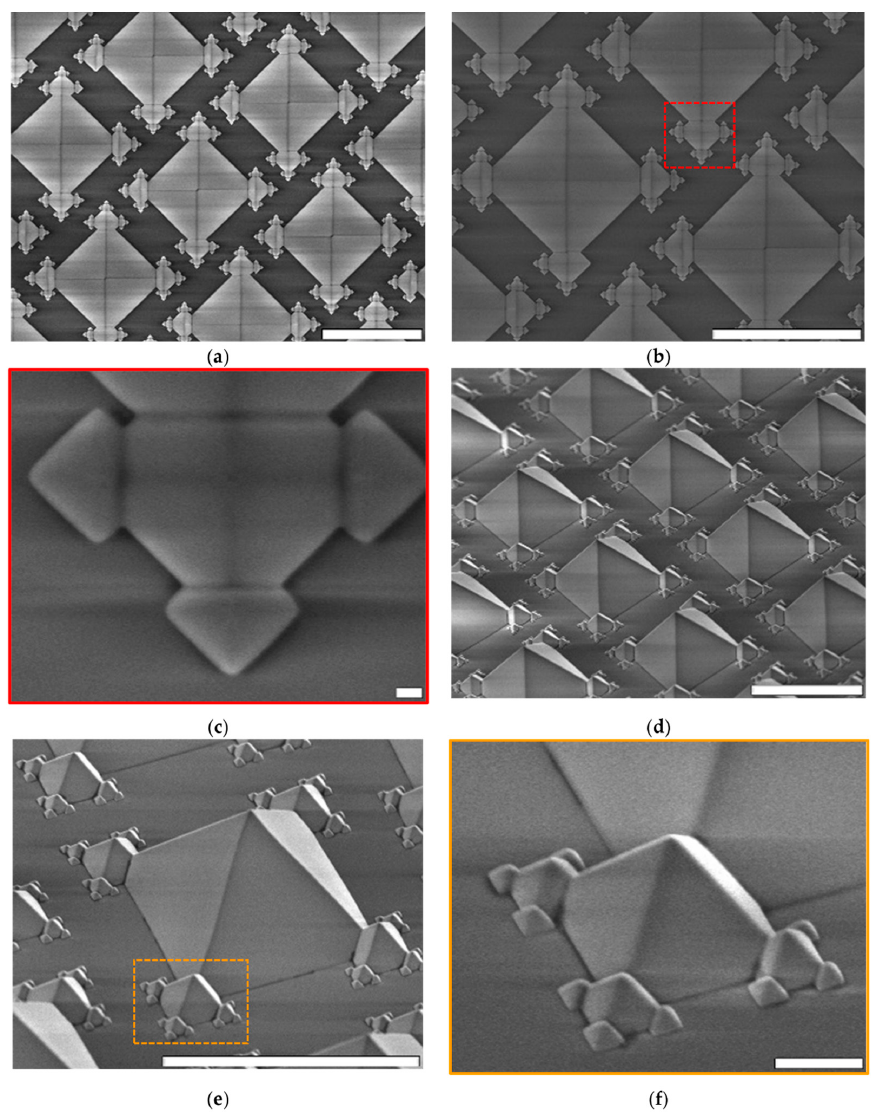
Figure 17. SEM top-view images ( a – f ) of G4 in-plane fractals after final thermal oxidation and anodic bonding and back-side etching in TMAH. ( d – f ) Substrate was 45° tilted. Enlarged areas are indicated in coloured dashed line. The charge-up effect in the SEM image is present due to the nonconductive SiO 2 layer. Enlarged areas are indicated in red and orange dashed lines. Scalebars: ( a , b , d , e ) 10 µm, ( c ) 100 nm and ( f ) 1 µm.